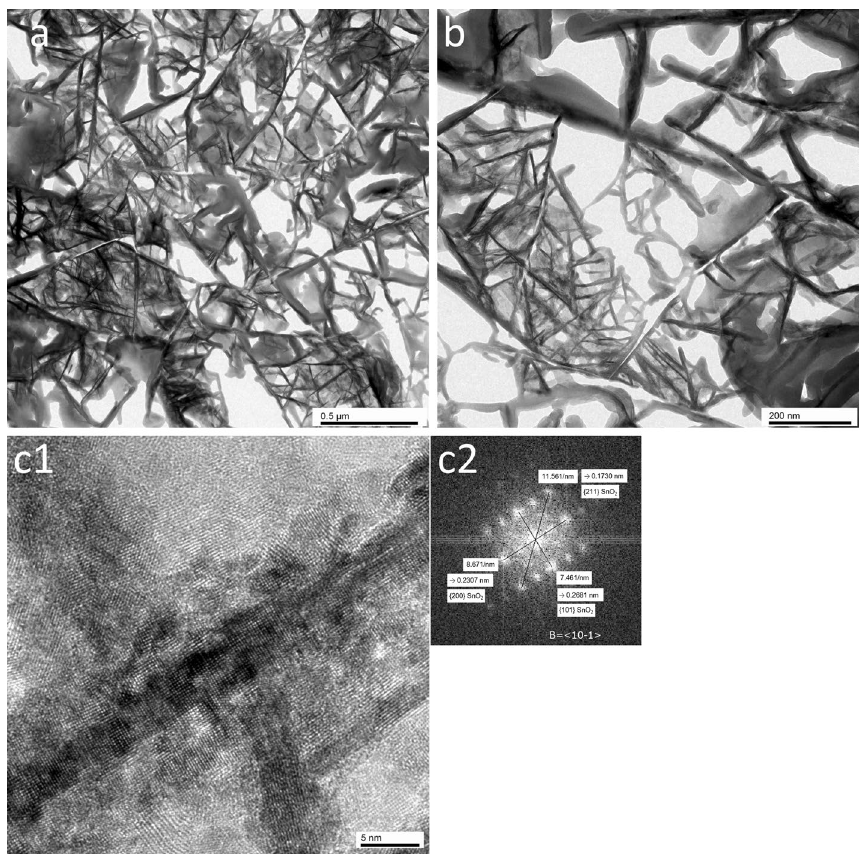
Figure 3. ( a ) Plane-observed TEM image of the SnO 2 (101) nanosheet assembled film. ( b ) Magnified image of an area of ( a ). ( c1 ) High-resolution plane-observed TEM image of the SnO 2 (101) nanosheet. ( c2 ) FFT image of ( c1 ) showing the lattice spacings of {101}, {200}, and {211}.